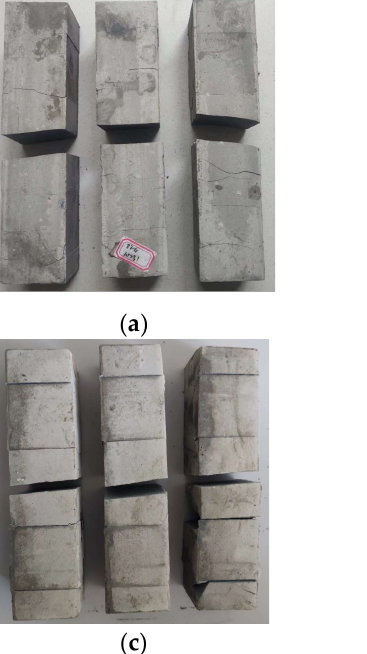
Figure 12. Compressive damage of geopolymer specimens with different slag content and age. ( a ) Slag content: 30%, age: 3d; ( b ) Slag content: 30%, age: 28d; ( c ) Slag content: 50%, age: 3d; ( d ) Slag content: 50%, age: 28d.